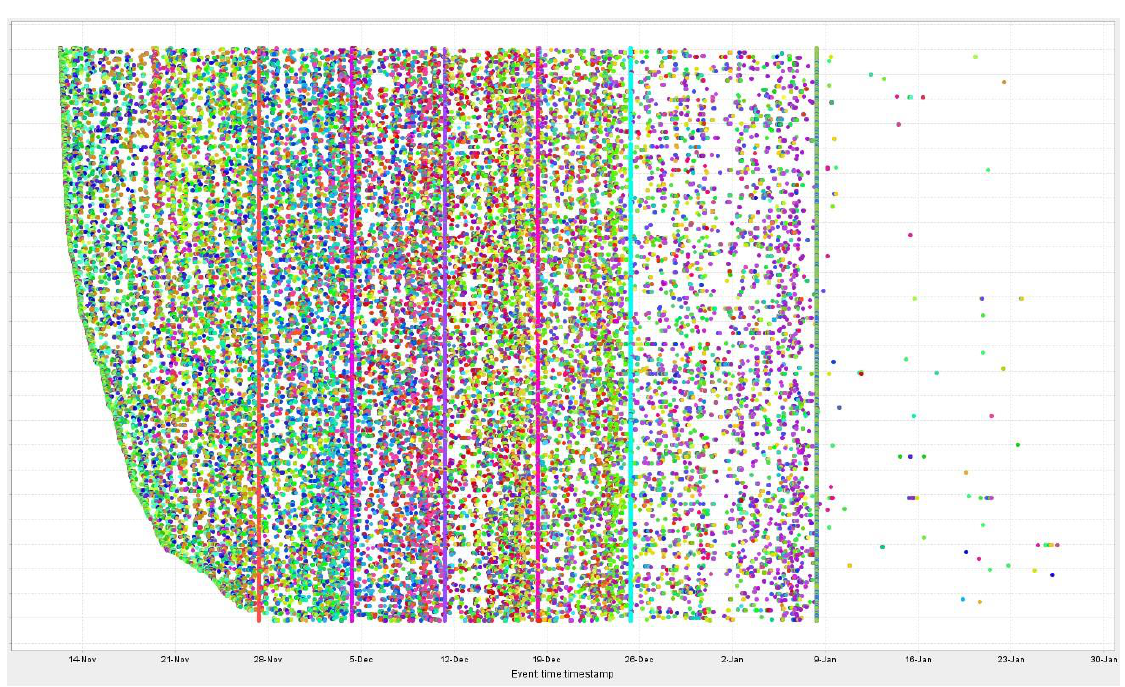
Figure 10. Video watching trends for cluster